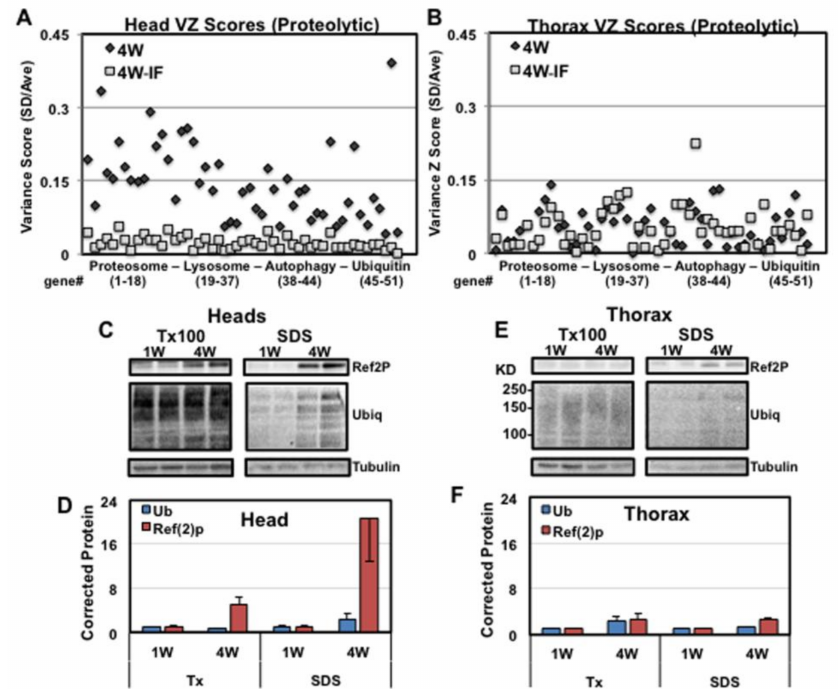
Figure 6. Age and IF-dependent tissue specific changes to proteolytic pathway variance and aggregate profiles. DAVID analysis was performed on neural transcripts that showed an age-related elevation and IF-reduction in TD variance scores (4W/4W-IF, >3.75). ( A ) Scatter plot of scaled variance Z scores (SD/Ave) of proteolytic pathway components from 4W ( ) to 4W-IF ( (cid:4) ) head transcriptomes. ( B ) The scaled variance Z scores (SD/Ave) for the same cohort of genes from replicate 4W ( ) to 4W-IF ( (cid:4) ) thoracic transcriptomes. See Tables S7 and S8 for individual gene information. Head and thoracic tissues from 1W to 4W flies underwent sequential detergent fractionation before Western analyses. Blots containing the Triton-X100 and SDS soluble protein fractions were probed with ant-UB, anti-Ref(2)P and anti-Tubulin antibodies and corrected protein levels quantified for both ( C , D ) head and ( E , F ) thoracic tissues. At 4 weeks of age, neural tissues demonstrated the buildup of protein aggregates, which is limited in age-matched thoracic